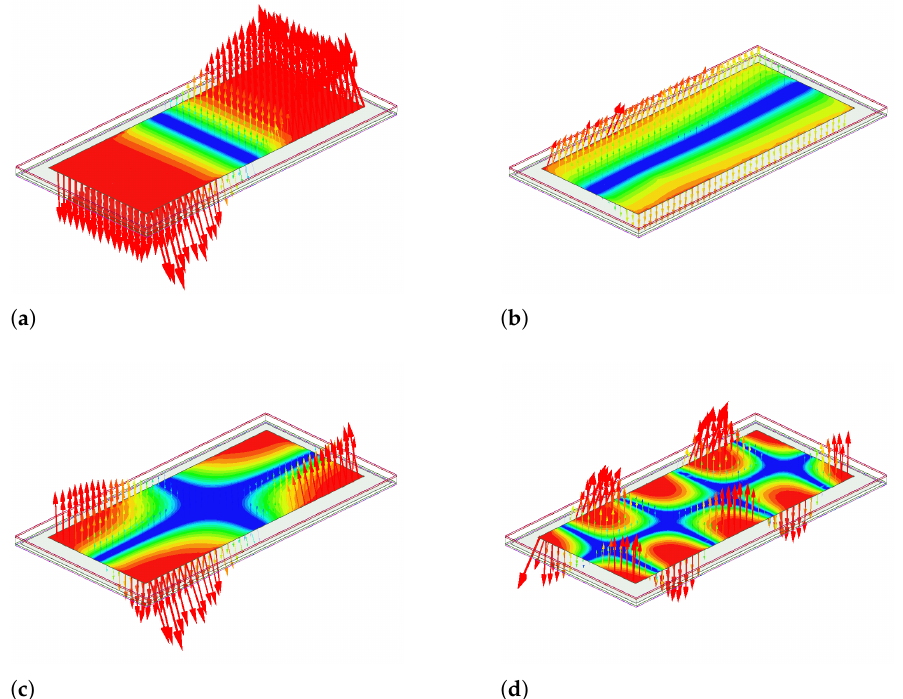
Figure 1. Electric field patterns for a sample of transverse magnetic (TM) resonant modes within a four-layer printed circuit board (PCB): ( a ) TM 10 , ( b ) TM 01 , ( c ) TM 11 , and ( d ) TM 41